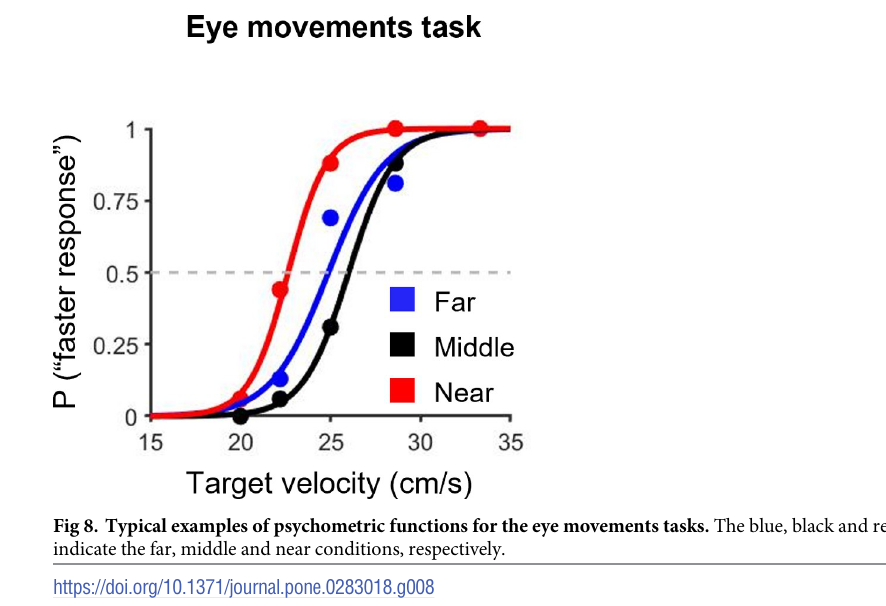
PLOS ONE | https://doi.org/10.1371/journal.pone.0283018 March 16,